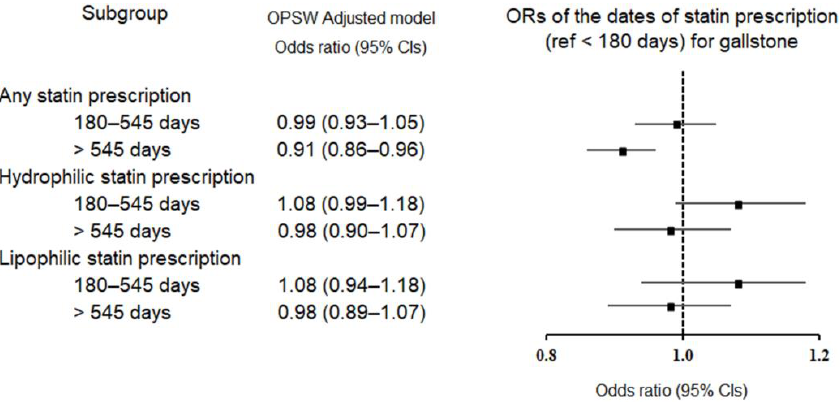
Figure 1. Forest plot depicting overlap propensity-score-weighted (OPSW) odds ratios (95% confi- dence intervals [CIs]) of incident gallstones according to statin type and duration of statin prescription. The reference period is <180 days.